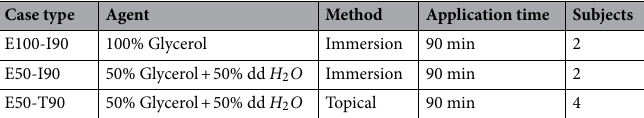
Table 6. Three different case types of the ex vivo optical clearing